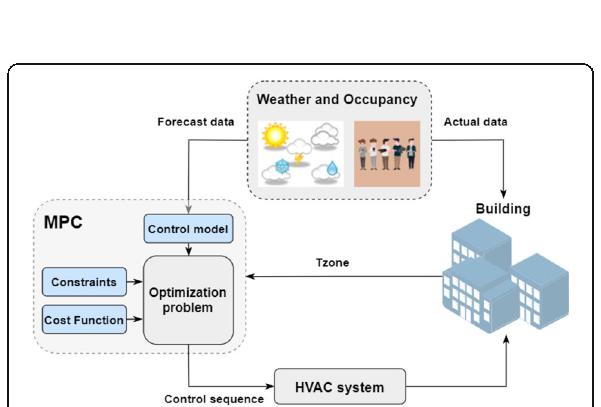
Fig. 2 (Abstract P1). Example of building MPC (Tzone is temperature in building